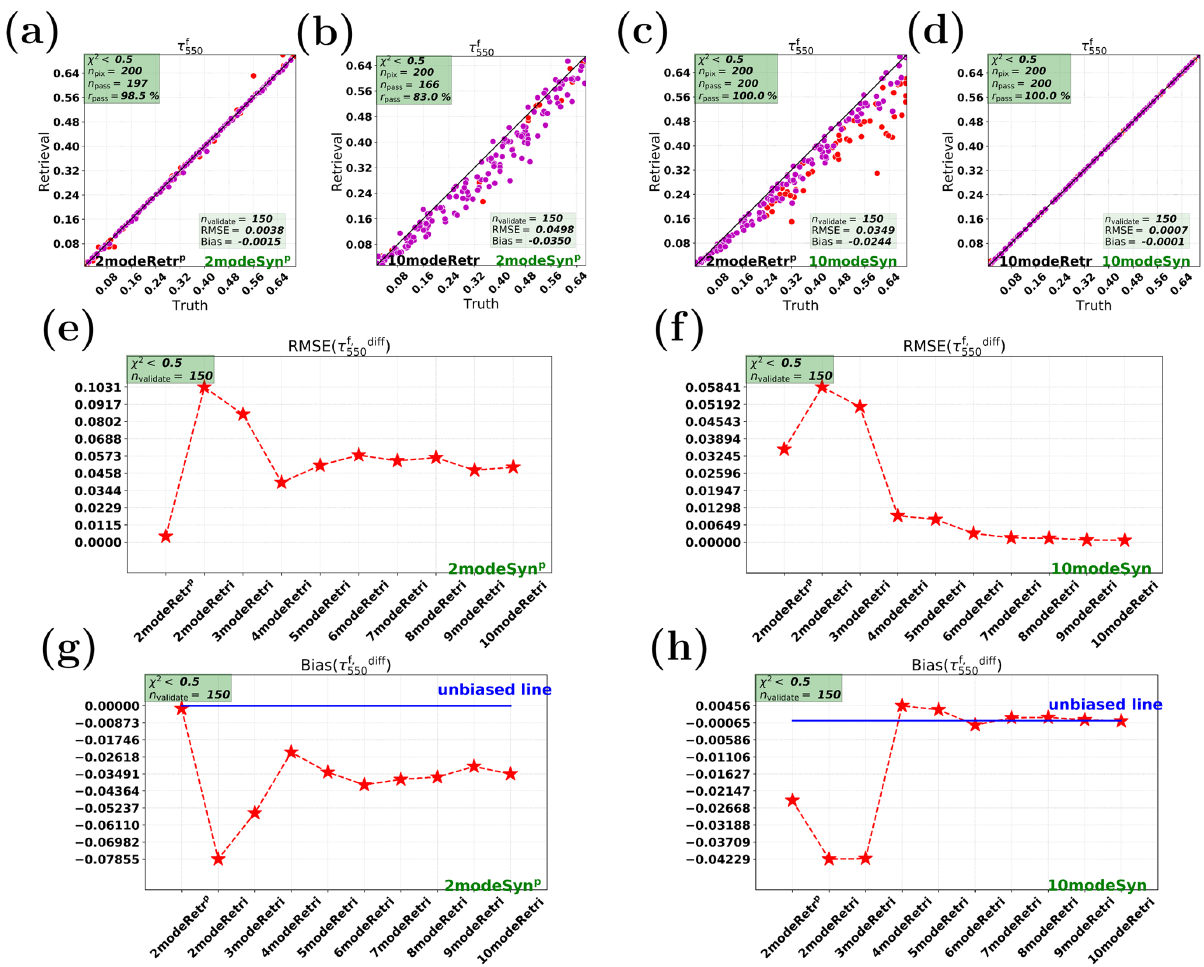
Figure 3. Synthetic retrievals for the AOT (at 550nm) of all the fine modes ( τ f ). The left panels (i.e., a, b, e, g ) and the right panels (i.e., 550 c, d, f, h ) are for cases on 2modeSyn p and 10modeSyn, respectively. Panels (a–d) show the parametric two-mode retrieval (2modeRetr p ) and the 10-mode retrieval (10modeRetr). Panels (e, f) show RMSE and (g, h) show bias for different retrieval cases.